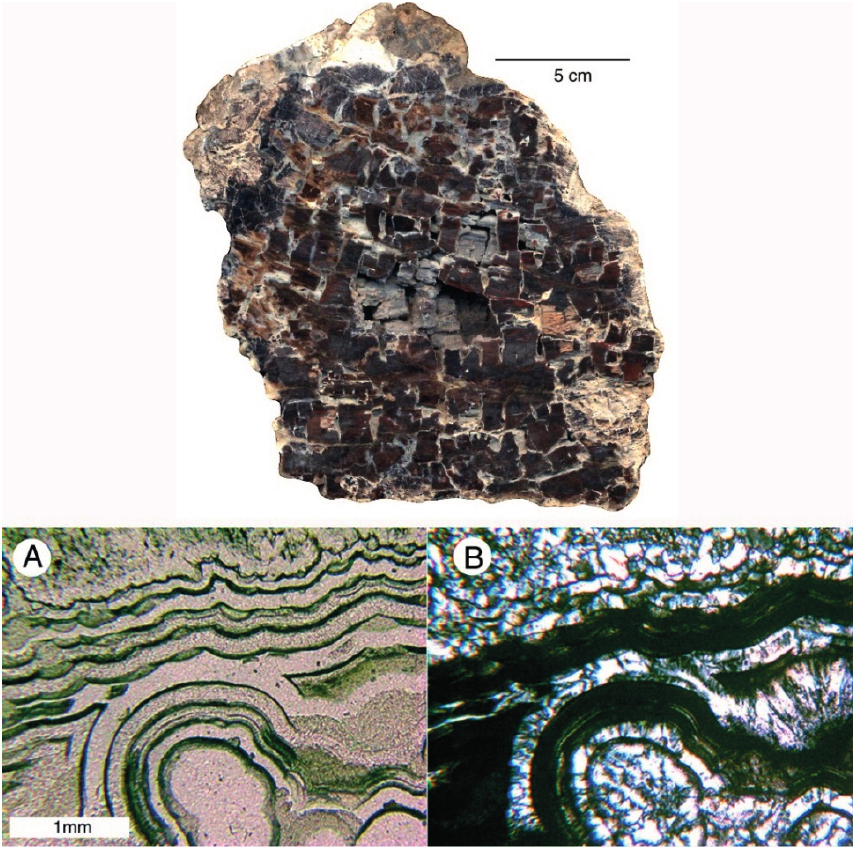
Figure 20. In geodes, veins, and silicified wood, silica minerals may occur in alternating layers. This photomicrograph pair shows minerals in a decay space in fossil wood from locality 4. ( A ) Ordinary transmitted light, showing dark opal-CT and colorless chalcedony; ( B ) polarized light, revealing chalcedony as bright birefringent